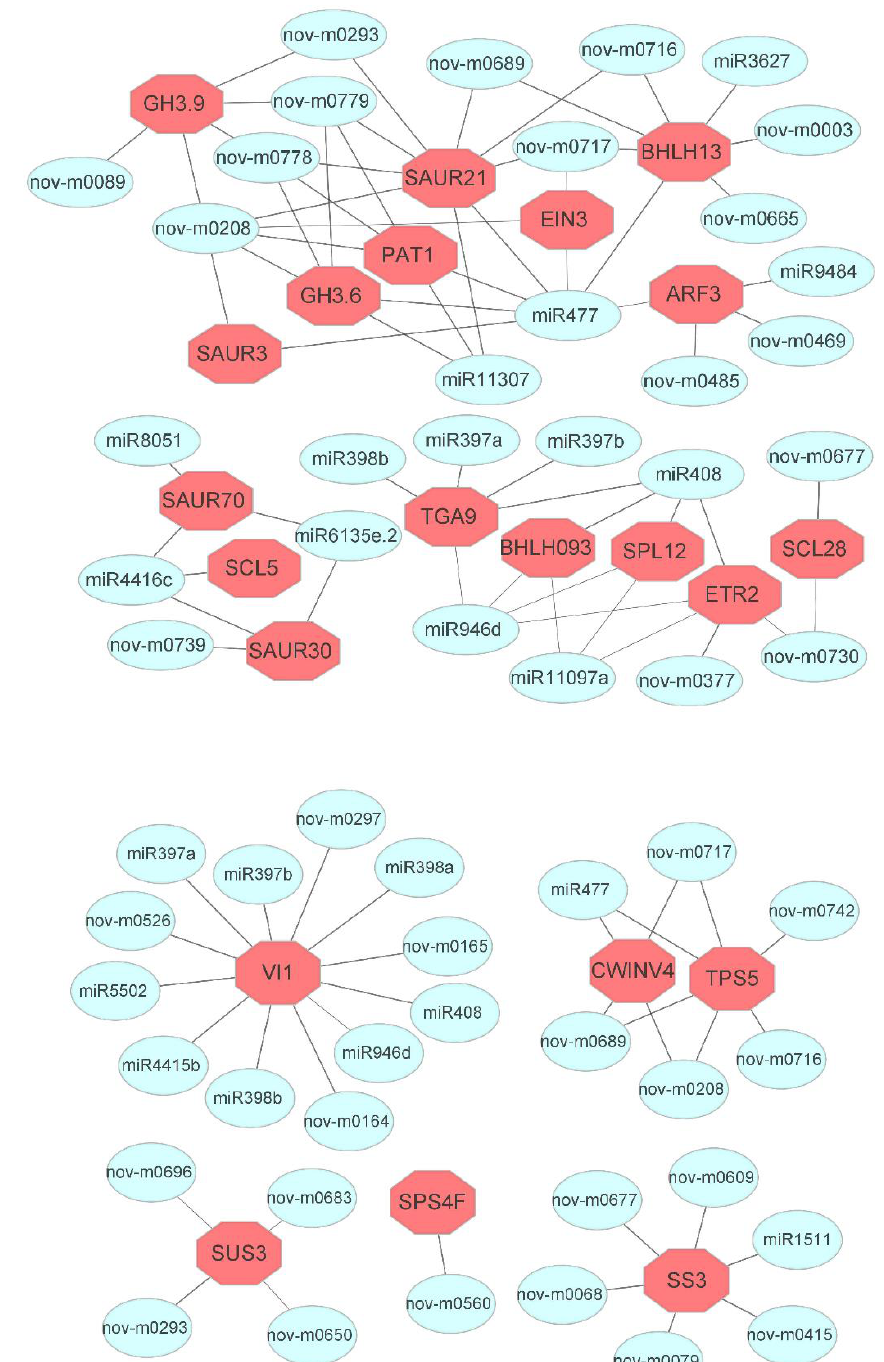
Figure 6. Co-expression network of the miRNAs and their targeted genes expressed in dark-pretreated micro-shoot cuttings of tetraploid R. pseudoacacia L. during IBA-dependent AR formation. Co-expression network of miRNAs and their targets during plant hormone signal transduction and sucrose metabolism pathways at five time points.